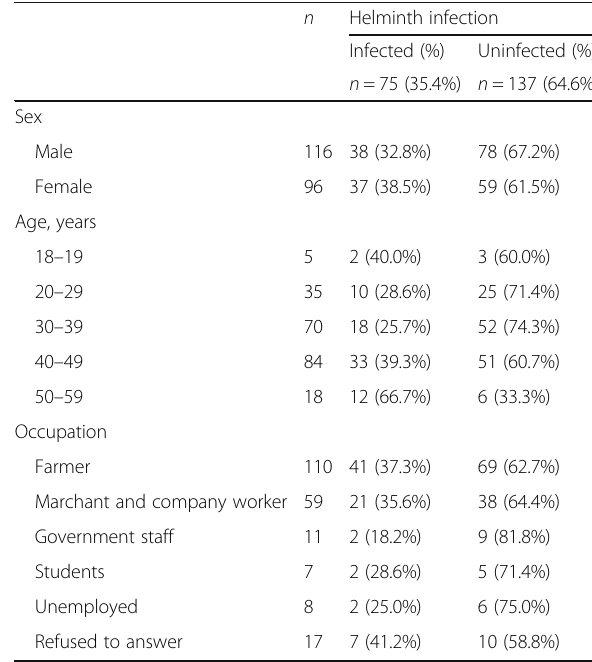
Table 2 Prevalence of intestinal helminths according to